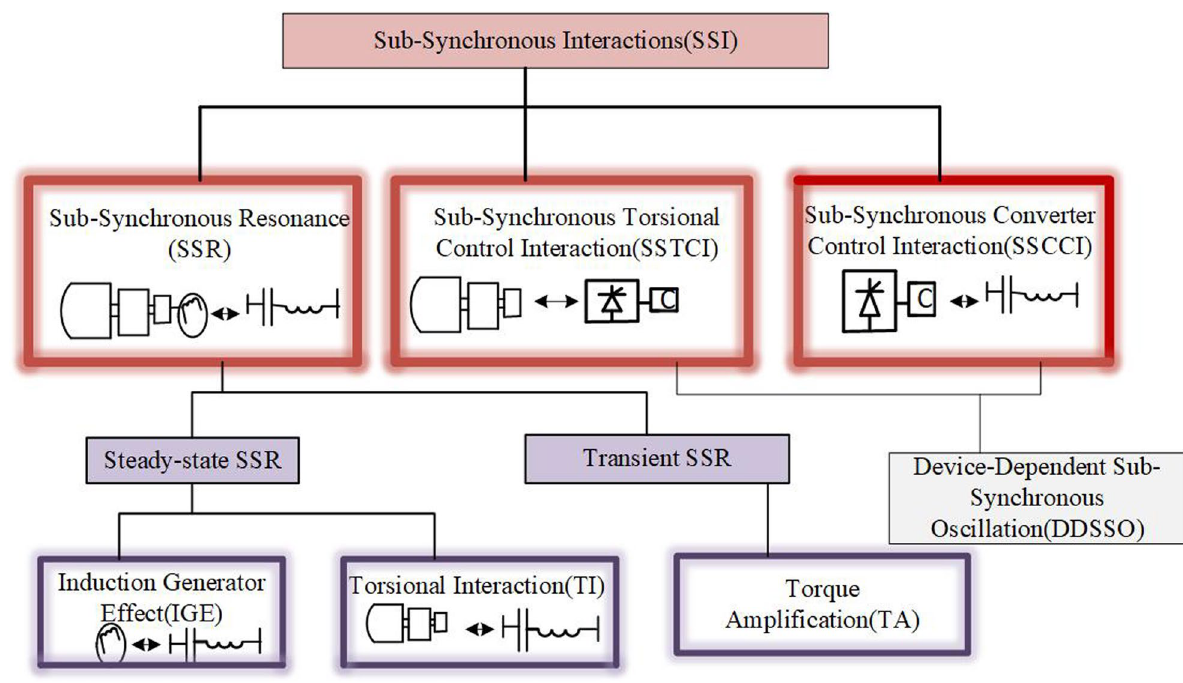
Fig. 3 Proposed classification of